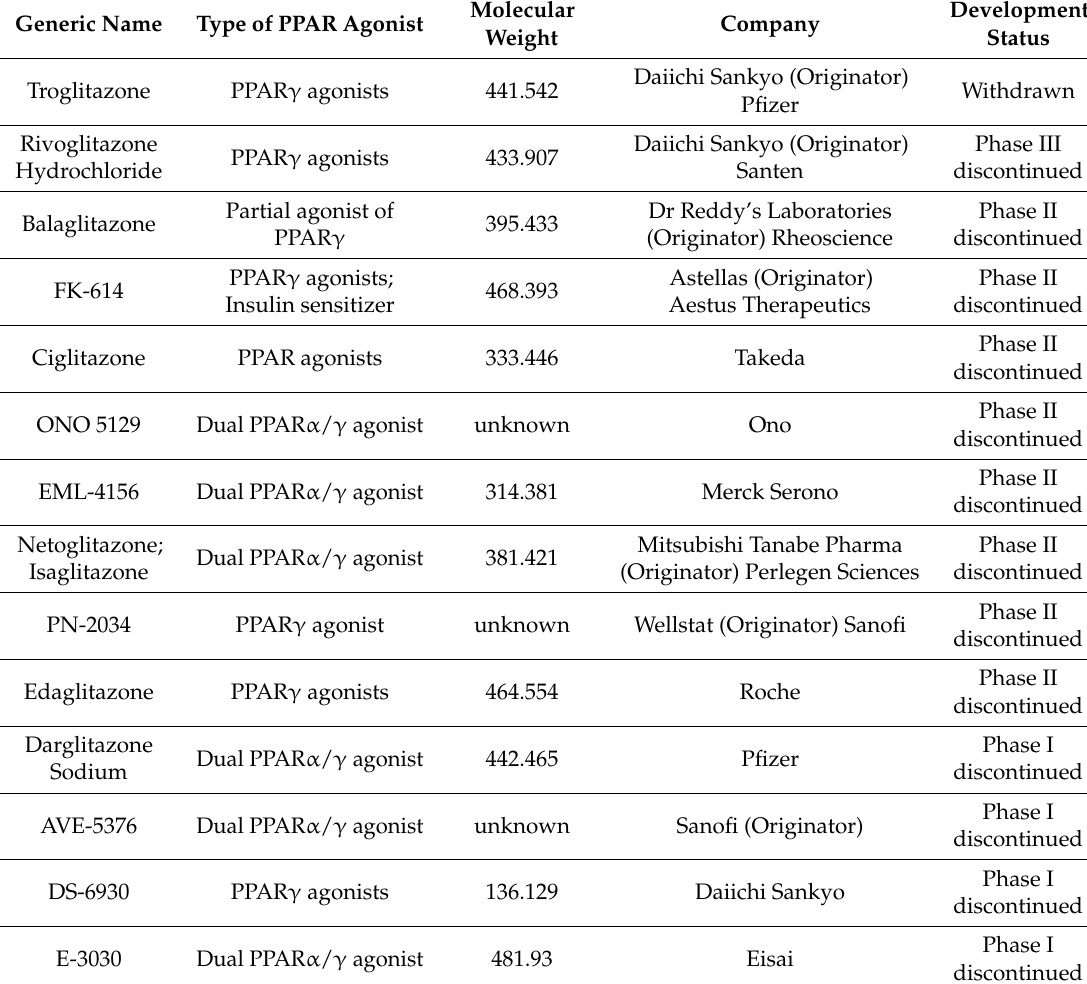
Table 5. Drugs of PPAR ligands for treatment of type 2 diabetes discontinued in clinical